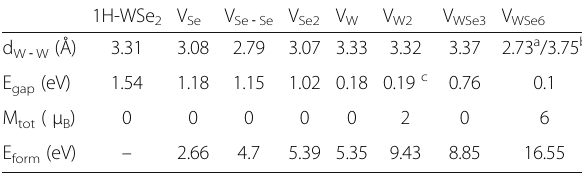
Table 1 The calculation results for monolayer WSe 2 with V Se , V Se-Se , V Se2 , V W , V W2 , V WSe3, and V WSe6 vacancies